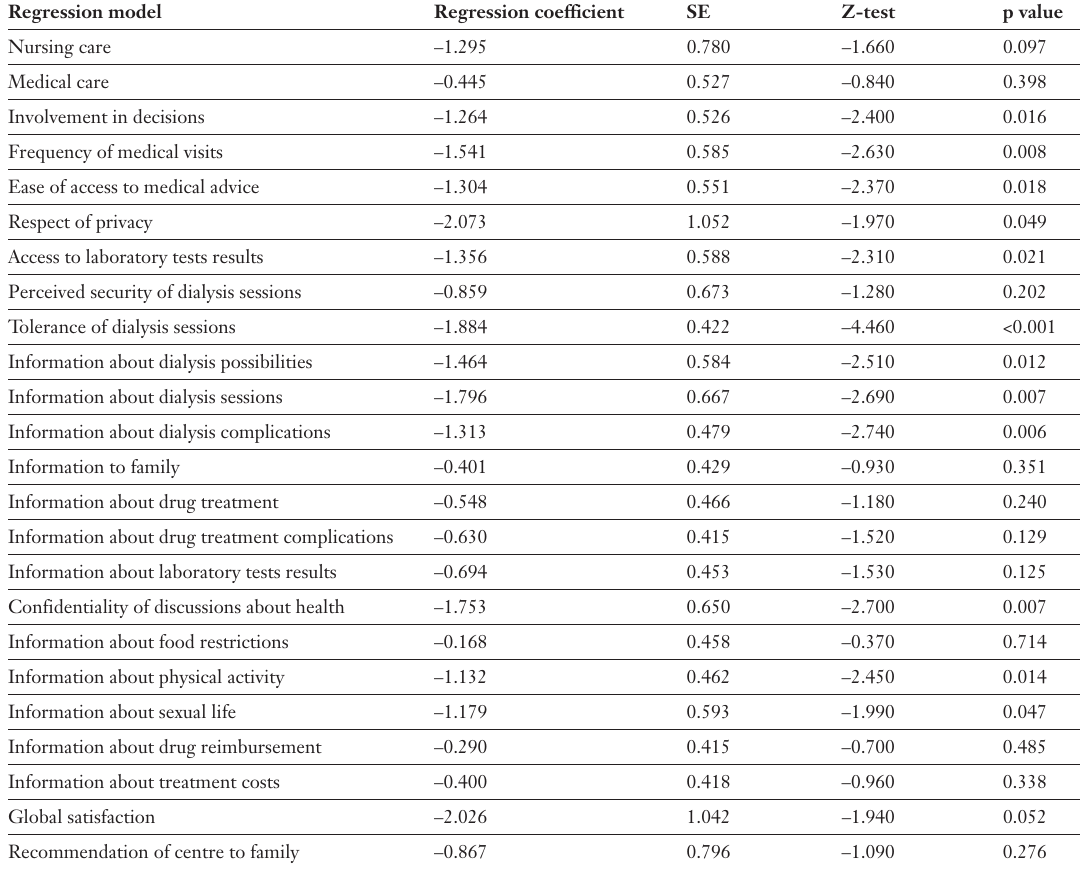
Table 4 Difference between haemodialysis and peritoneal dialysis in the 9 centres offering both treatment modalities (mixed